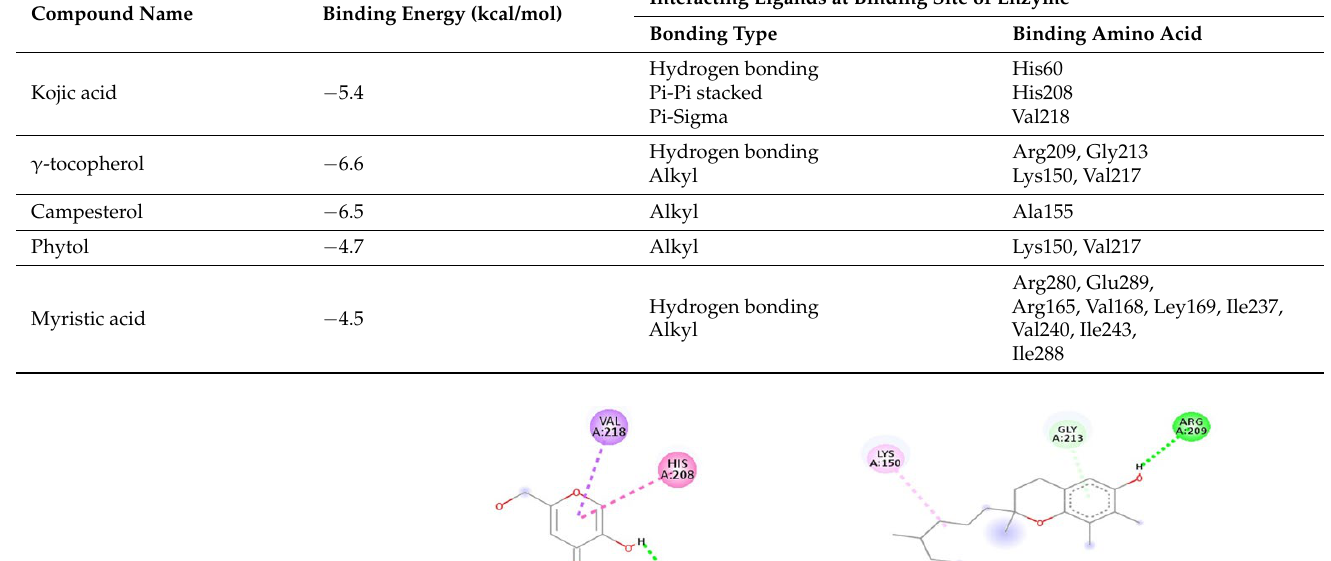
Table 4. The binding affinity of ligands and tyrosinase enzyme.